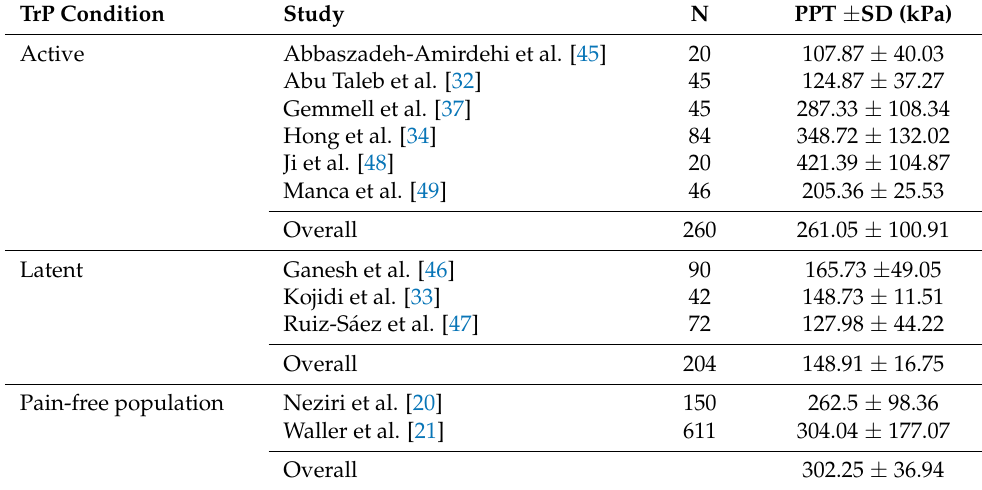
Table 4. Results for active and latent trigger